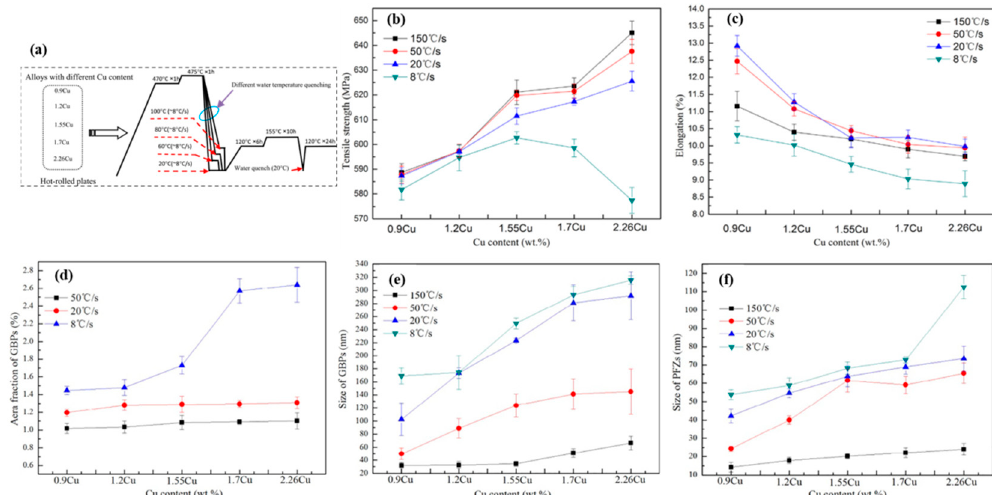
Figure 12. ( a ) Schematic diagram of heat treatment processing for alloys; ( b , c ) Tensile strength and elongation curve of the well-quenched and aged samples treated by different quench rate; ( d ) Effect of Cu content and quench rate on area fraction of GBPs in alloys; ( e , f ) Effect of Cu content and quench rate on the size of GBPs and width of PFZs in alloys. (Reprinted from ref. [114]).